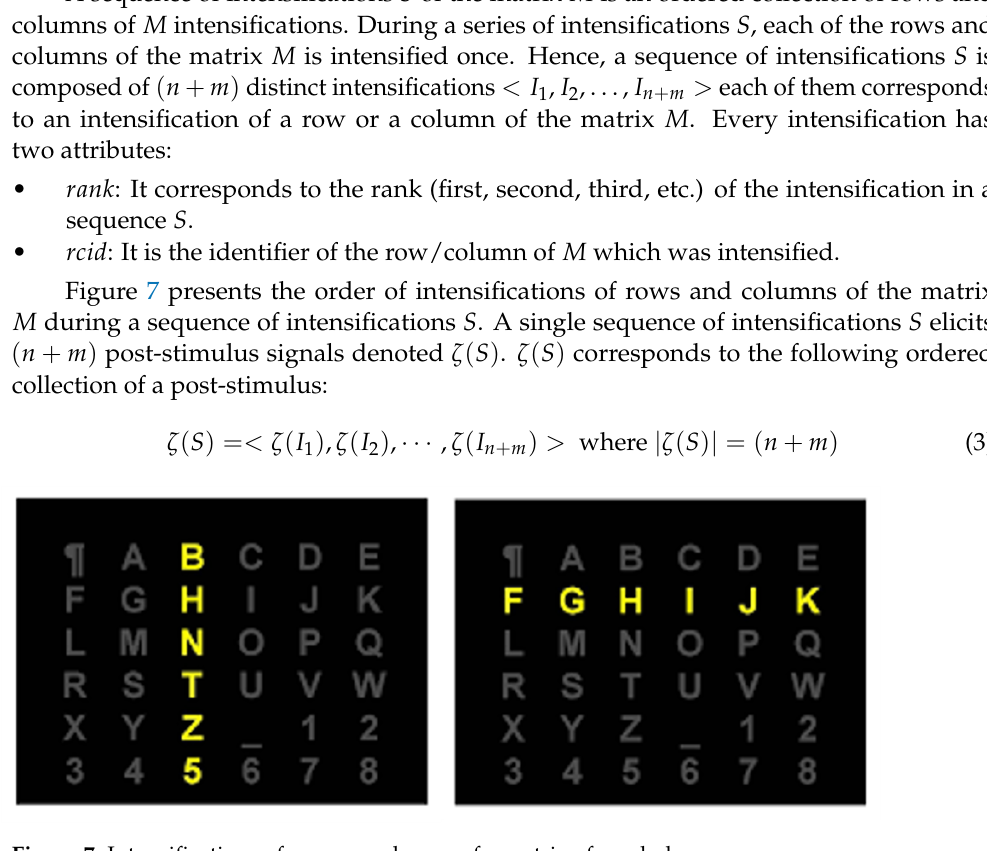
Figure 7. Intensifications of rows or columns of a matrix of